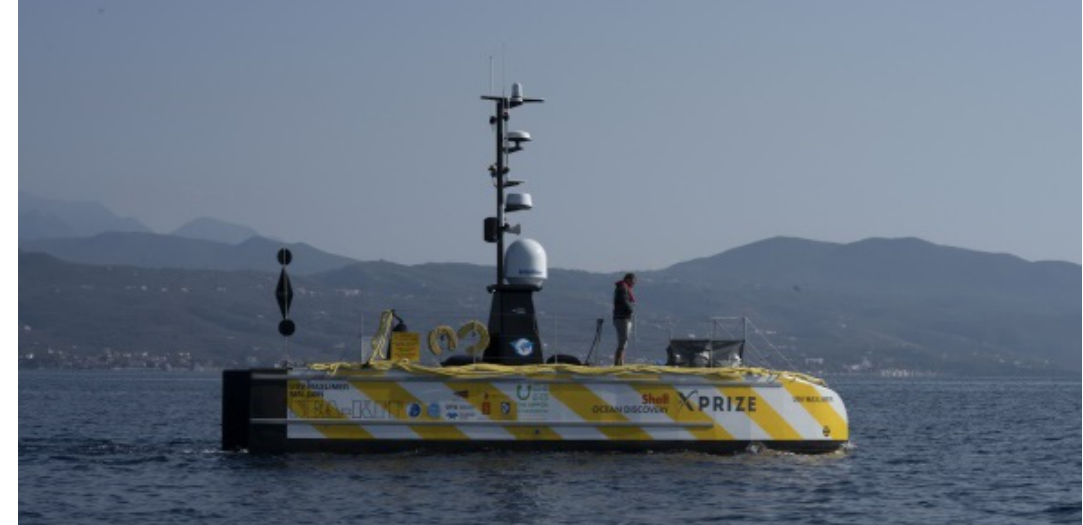
Figure 2. USV SEA-KIT ’Maxlimer’ during the preparation to the final survey, Kalamata, Greece: the surface part of the mapping devices set used in Round 2 of Shell Ocean Discovery XPRIZE (Photography by XPRIZE).